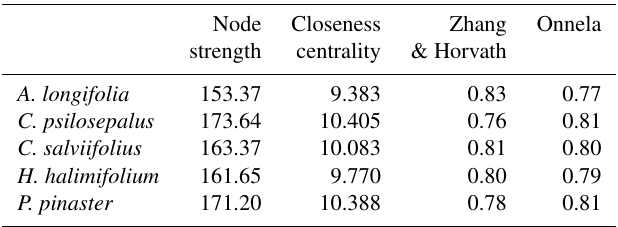
Table 5. Topological indexes based on the network obtained with the Euclidian distances between each plant fungal community. Be- tweenness centrality, represented here by the node strength, close- ness centrality and clustering coefficients (Zhang and Horvath; On- nela) indicate the importance and influence of each community in the network. Node Closeness Zhang Onnela strength centrality